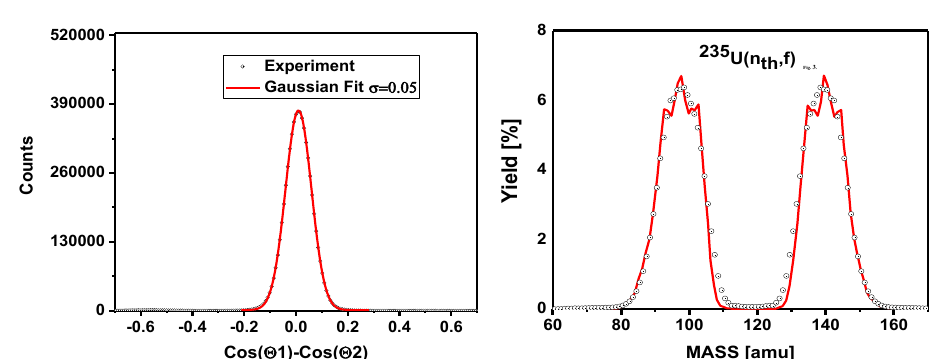
Fig. 2. Demonstration the precision of cos(ϴ) measurement in the range 0.5<cos(ϴ)<1.0 (on the left). Comparison of measured mass yield (dots) with data (solid line) taken from Ref.[4]. For calculations the successive approximation procedure to obtain pre-PFN emission mass described in Ref. [3] was used (on the